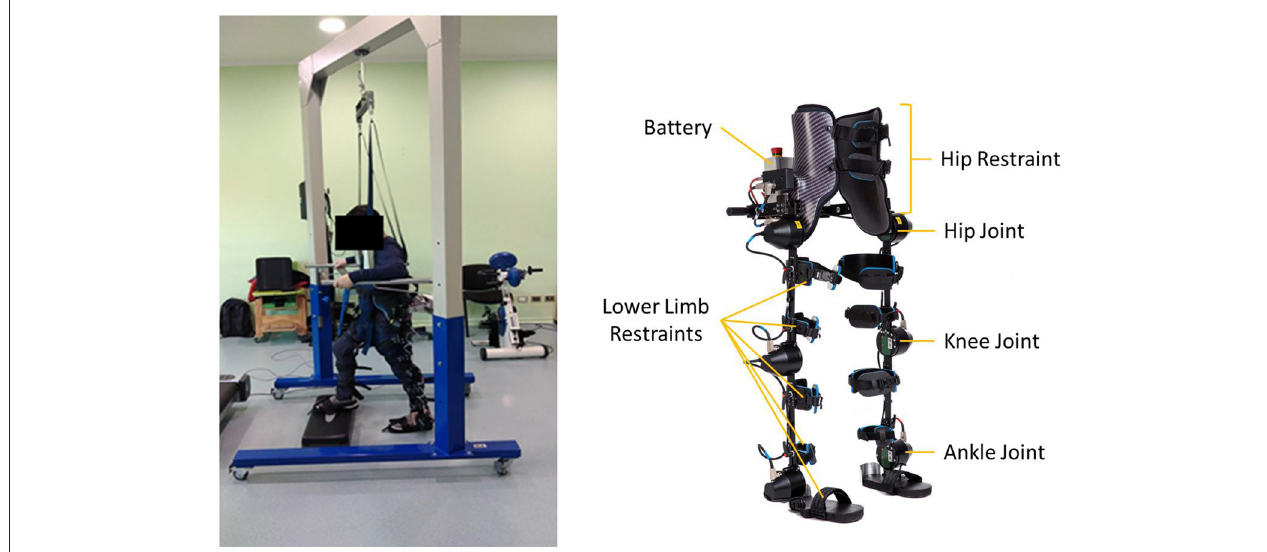
FIGURE 1 | Exoskeleton